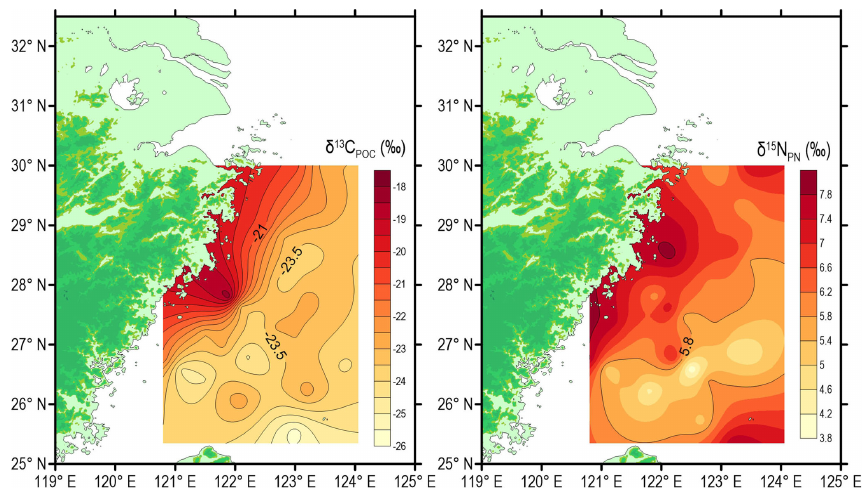
Figure 5. Spatial distributions of stable isotopic values of particulate organic carbon and nitrogen ( δ 13 C POC and δ 15 N PN ) around the deep chlorophyll maximum layer in the southern East China Sea during summer 2013.